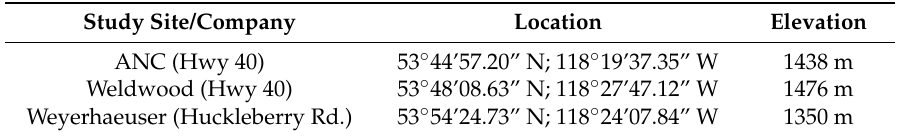
cover. ANC = Alberta Newsprint